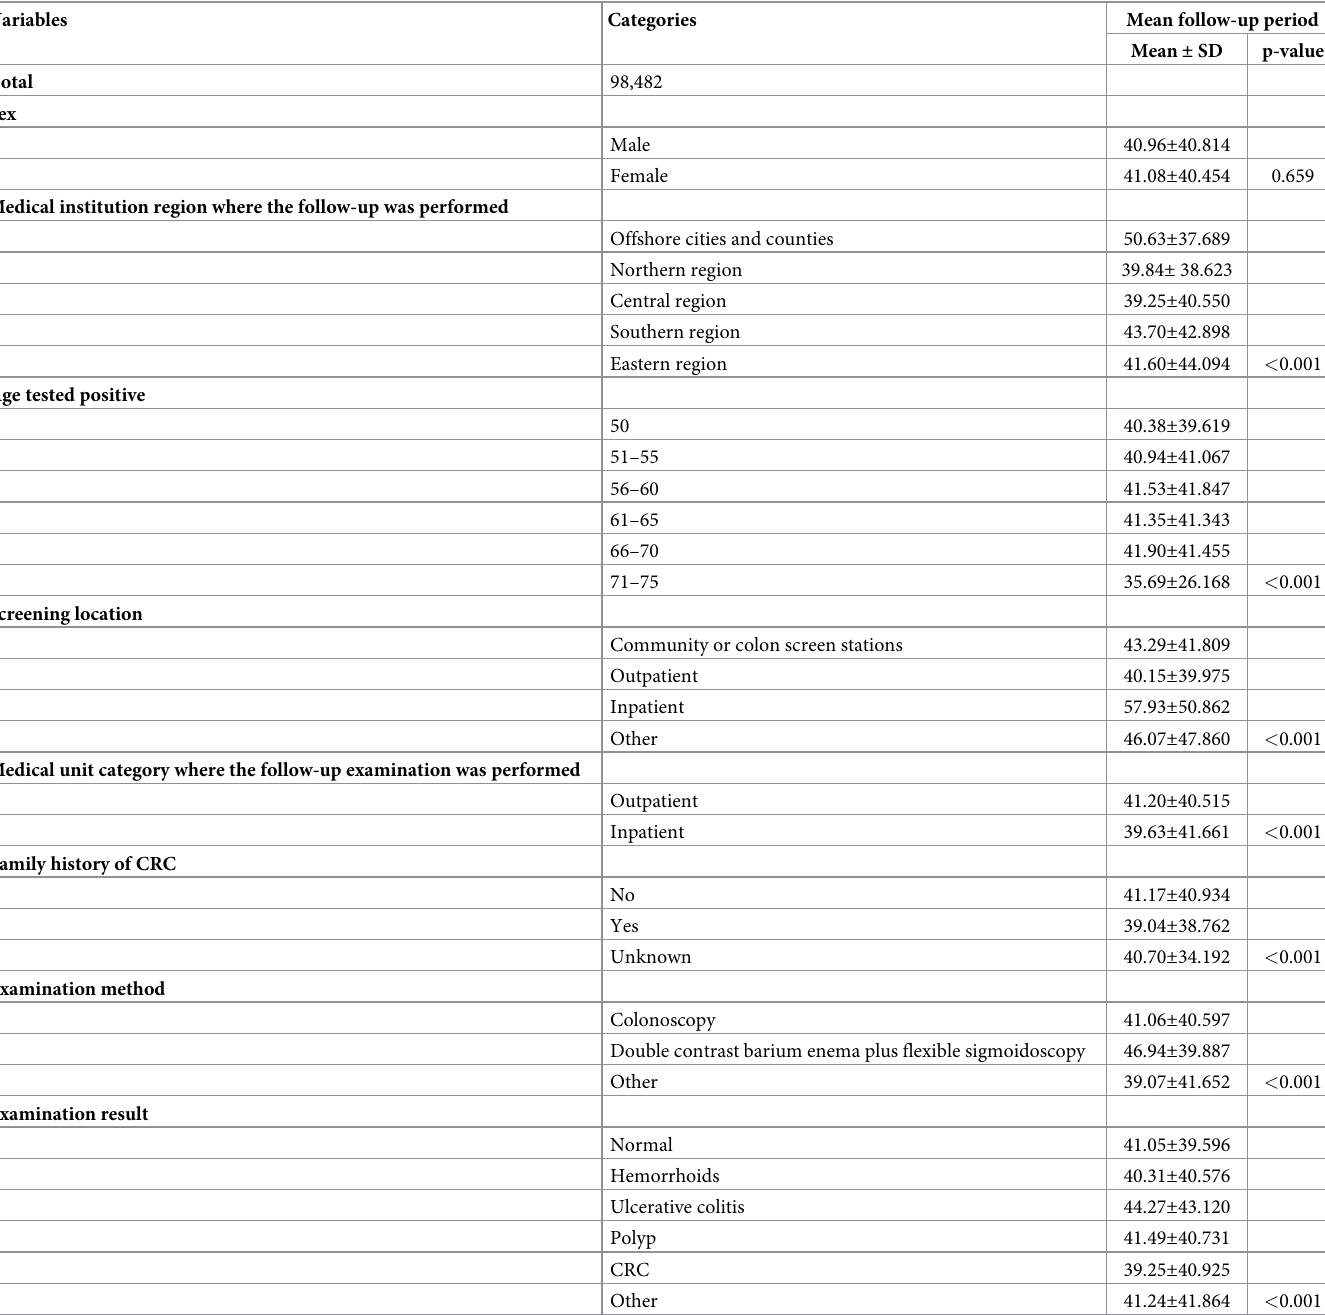
Table 3. Differences in mean follow-up time in people with positive FOBT results who have undergone follow-up